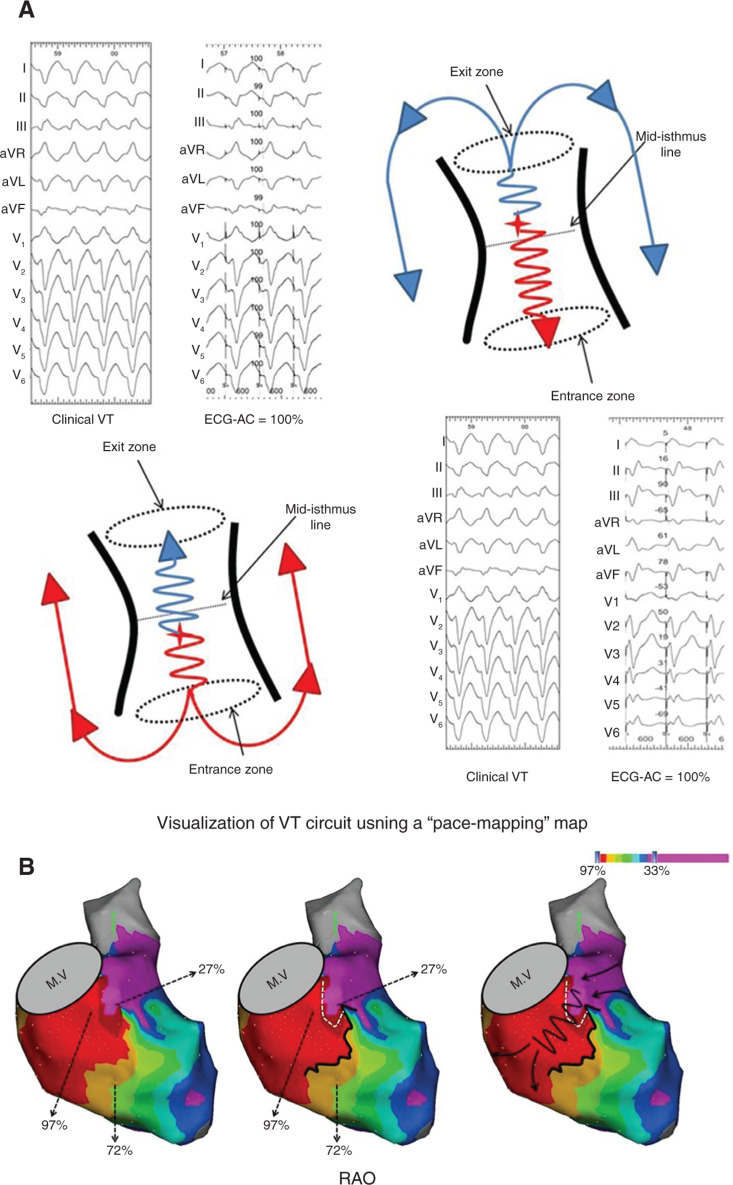
Pacemap localization of VT circuit. A: A schema of a “figure-of-eight” reentrant VT circuit. During sinus rhythm, when pacing at the exit side of the mid-isthmus line, the activation wavefront propagates in two directions, but more rapidly to the exit site, resulting in near-identical RS morphologies as that of clinical VTs with an ECG average correction (ECG-AC) of 100%. When pacing at the entrance side of the mid-isthmus, the wavefront propagates more rapidly to the entrance and away from the exit, resulting in different ventricular activation patterns and paced QRS morphologies, with a poor ECG correlation (ECGAG: 10%). B: Left: An example of a VT circuit visualized using a “pacemapping” map superimposed on the three-dimensional electroanatomic maps. The color gradient corresponds with the degree of ECG correlation as compared with the clinical VT (> 97% pacemap QRS match: red; < 33% QRS match: purple). Middle: A pacemapping map showing a good (97%) correlation zone, corresponding with the VT exit. Close to this zone, a poor (27%) correlation zone with an abrupt transition within a short distance is seen. In another direction, an abrupt transition is observed between the good correlation zone and a zone with an intermediate correlation (92%). Right: the abrupt transition line between the very good and the bad correlation zones defines the mid-isthmus line (white dashed line), while transition between the very good and intermediate correlation zones defines the lateral boundary of the isthmus (black line). ECG: electrocardiogram; MV: mitral valve; RAO: right anterior oblique; VT: ventricular tachycardia. Adapted from Al-Ahmad AA, Callans DJ, Hsia HH, et al. Hands-On Ablation: The Experts’ Approach. 2nd ed. Minneapolis, MN: Cardiotext Publishing, LLC; 2017. Used with permission from Cardiotext Publishing.